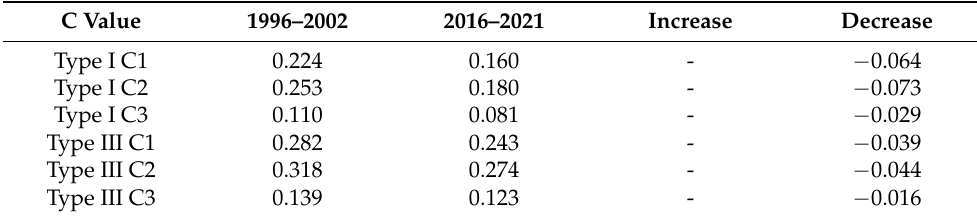
Table 4. 1996–2002 and 2016–2022 C value statistics.